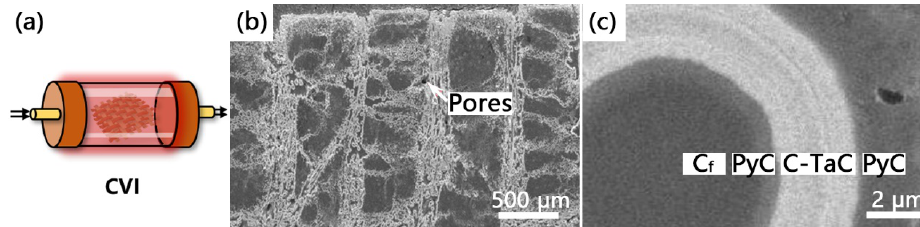
Fig. 15 Schematic diagram of CVI (a); microstructure of CVI–C f /C–TaC (b, c). Reproduced with permission from Ref. [214], © Elsevier B.V. 2013.